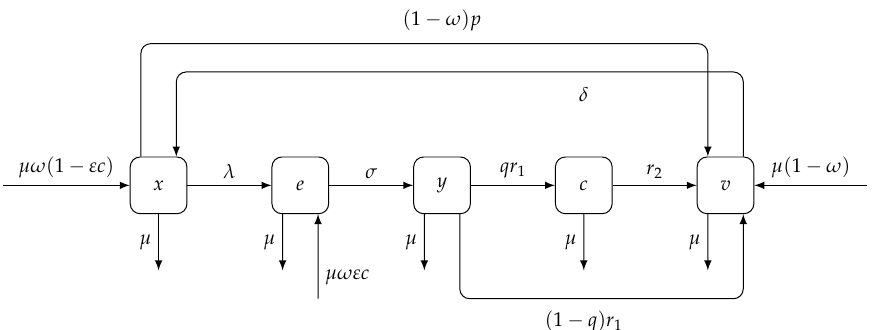
Figure 1. Compartmental model of Hepatitis B. The population is divided into five compartments: susceptible ( x ), exposed ( e ), acutely infected ( y ), chronically infected ( c ), and temporarily immune ( v ) individuals. Descriptions of parameters are given in Table